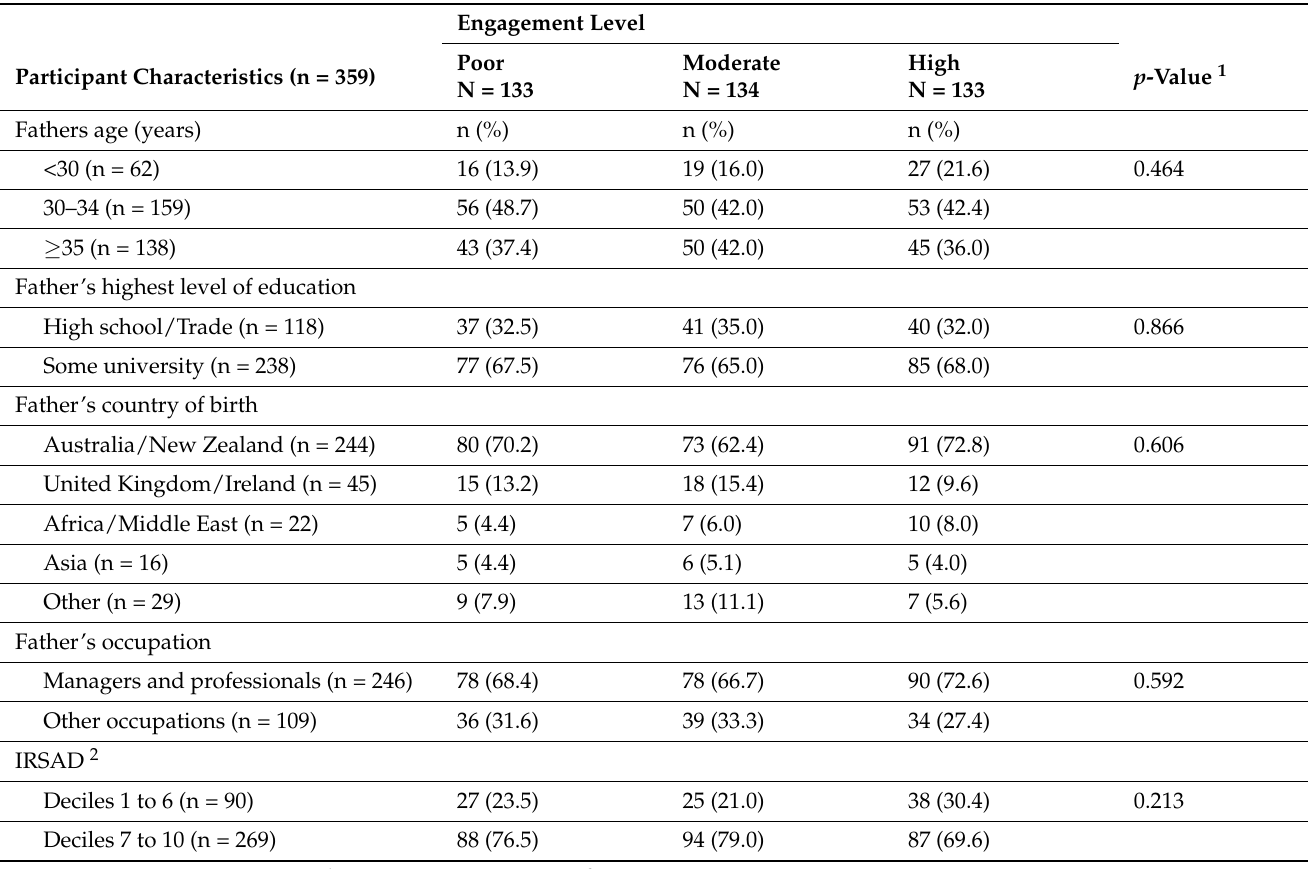
Table 2. Participant characteristics by engagement